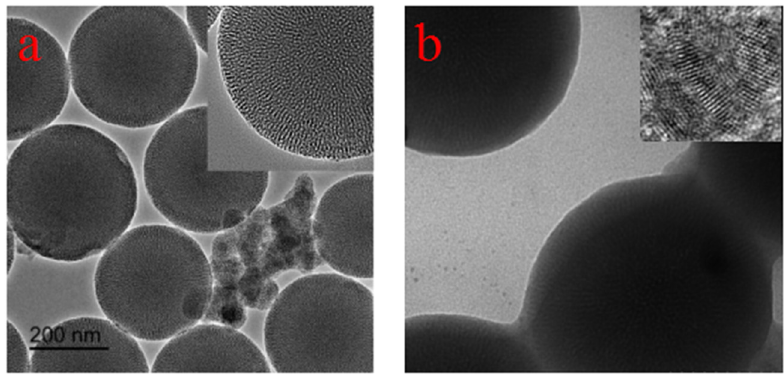
Figure 2: TEM images of ( a ) as - prepared mesoporous SiO 2 particles and ( b ) CQDs/mesoporous SiO 2 composites.